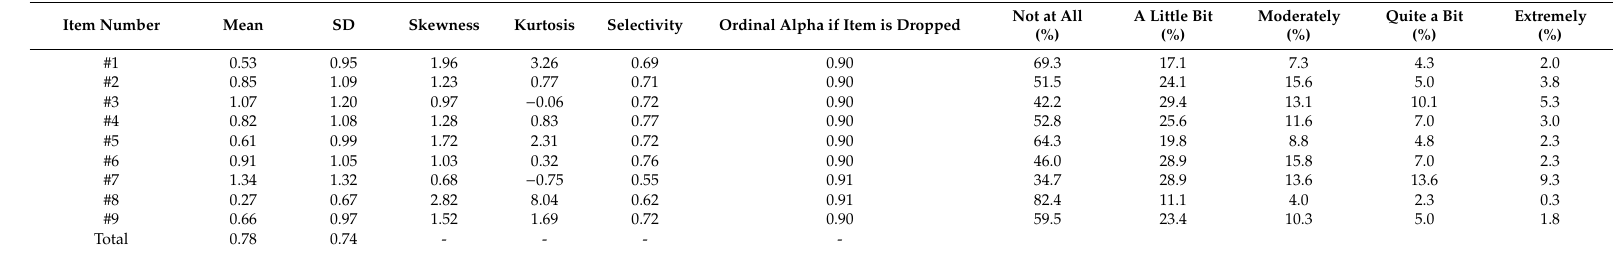
Table 2. Items statistics of the